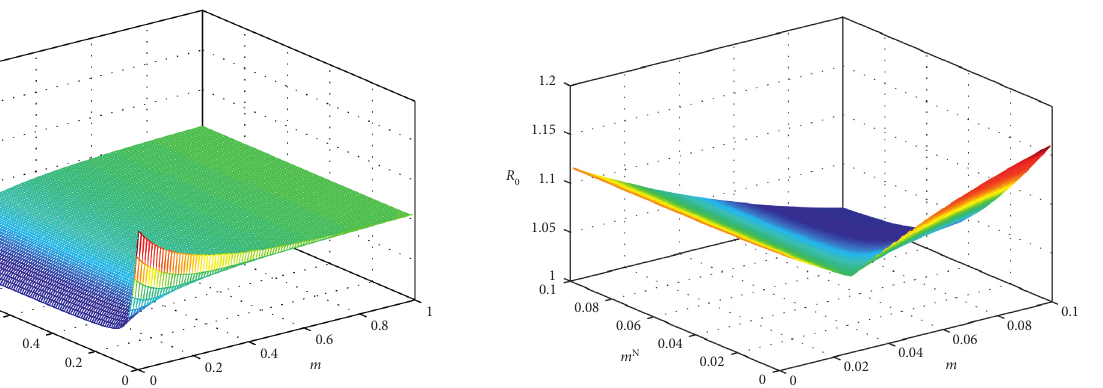
Figure 6: The effects of the diffusion rates on the net reproduction Figure 9: The effects of the diffusion rates on the net reproduction � 0 . 96, R � 1 . 1657, K � 2 . 8, K � 3, � 1 . 0286, R � 1 . 12, K � 3, K � 2 . 8, number R number R where R where R 0 01 02 1 2 0 01 02 1 2 � 0 . 18, d N � 0 . 16, and m N , m J � m A � m vary from 0.01 to 1; � 0 . 18, d N � 0 . 15, and m N , m J � m A � m vary from 0.01 to 1; d N d N 1 2 1 2 all other parameters are given in equation (71). all other parameters are given in equation (71).